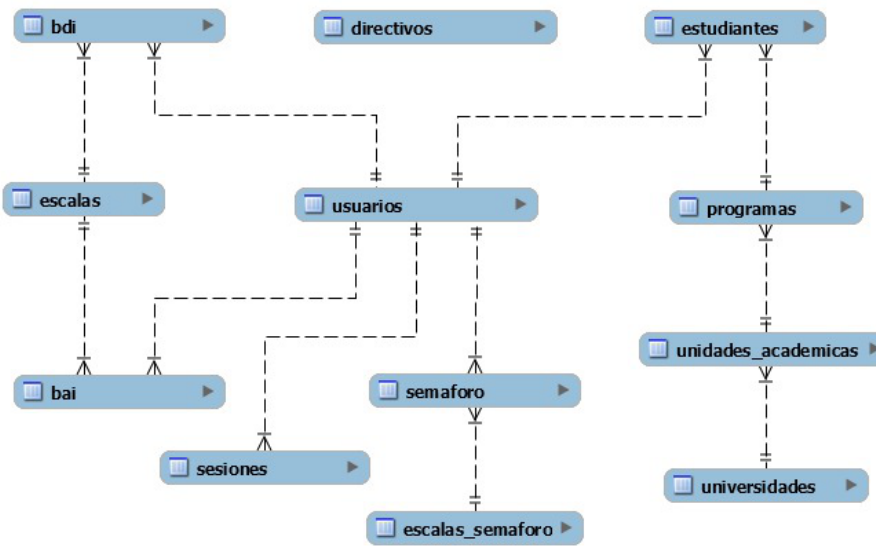
Figure 4. Mobile app database diagram. The diagram satisfies the requirements of the mobile application; feedback obtained in the first iteration was incorporated.